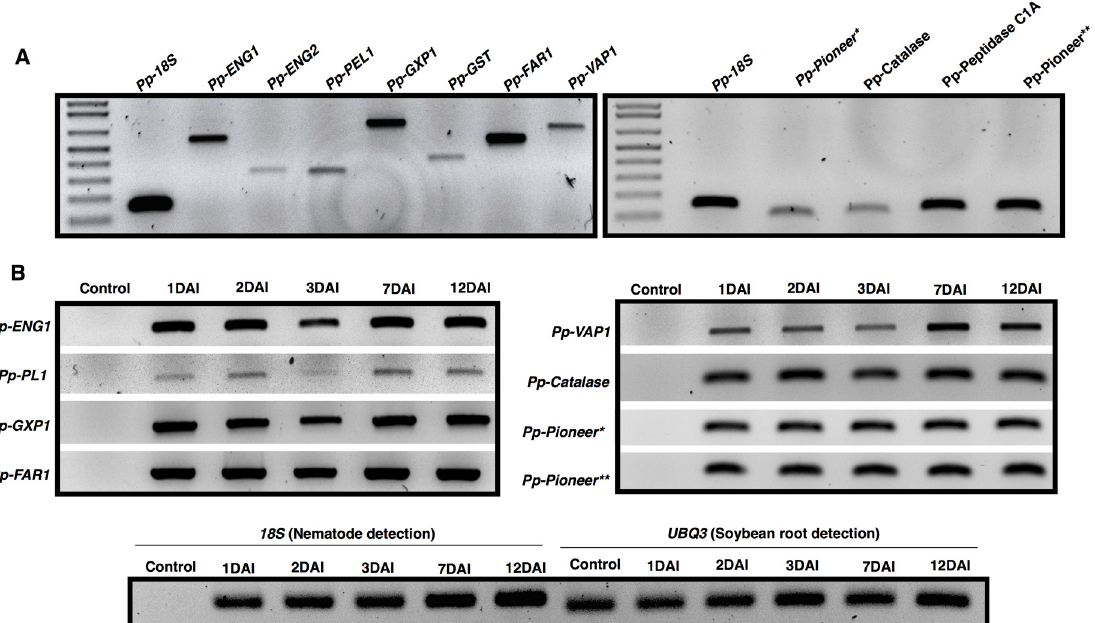
Fig 3. Semi-quantitative RT-PCR showing the transcript levels for a subset of predicted Pratylenchus penetrans transcripts. (A) RT-PCR amplification was performed using the generated cDNA from total RNA collected from a pool of mixed stages (eggs, juveniles and adult stages) of P . penetrans . (B) Upper panel: detection of a subset of P . penetrans genes putatively involved in parasitism using total RNA extracted from nematode infected soybean roots, at different days after nematode infection (1, 2, 3, 7 and 12 days after infection). Lower panel: the nematode 18S rDNA gene was used as control to validate the presence of P . penetrans in the infected roots, while UBQ3 gene was used to validate plant gene detection. Control corresponds to non-infected soybean roots.